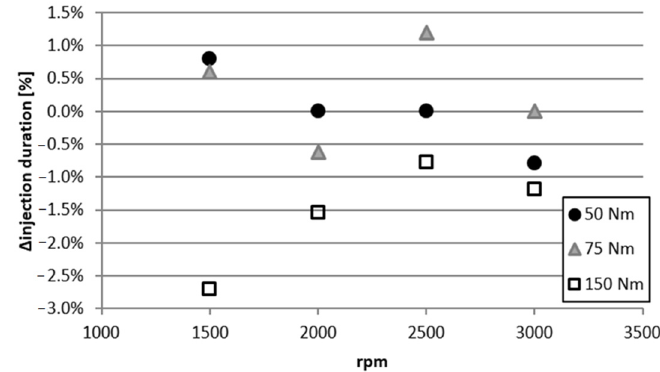
Figure 17. Difference in injection duration of M56 compared to E85 as a function of engine speed for different fixed brake torques of 50, 75, and 150 Nm.